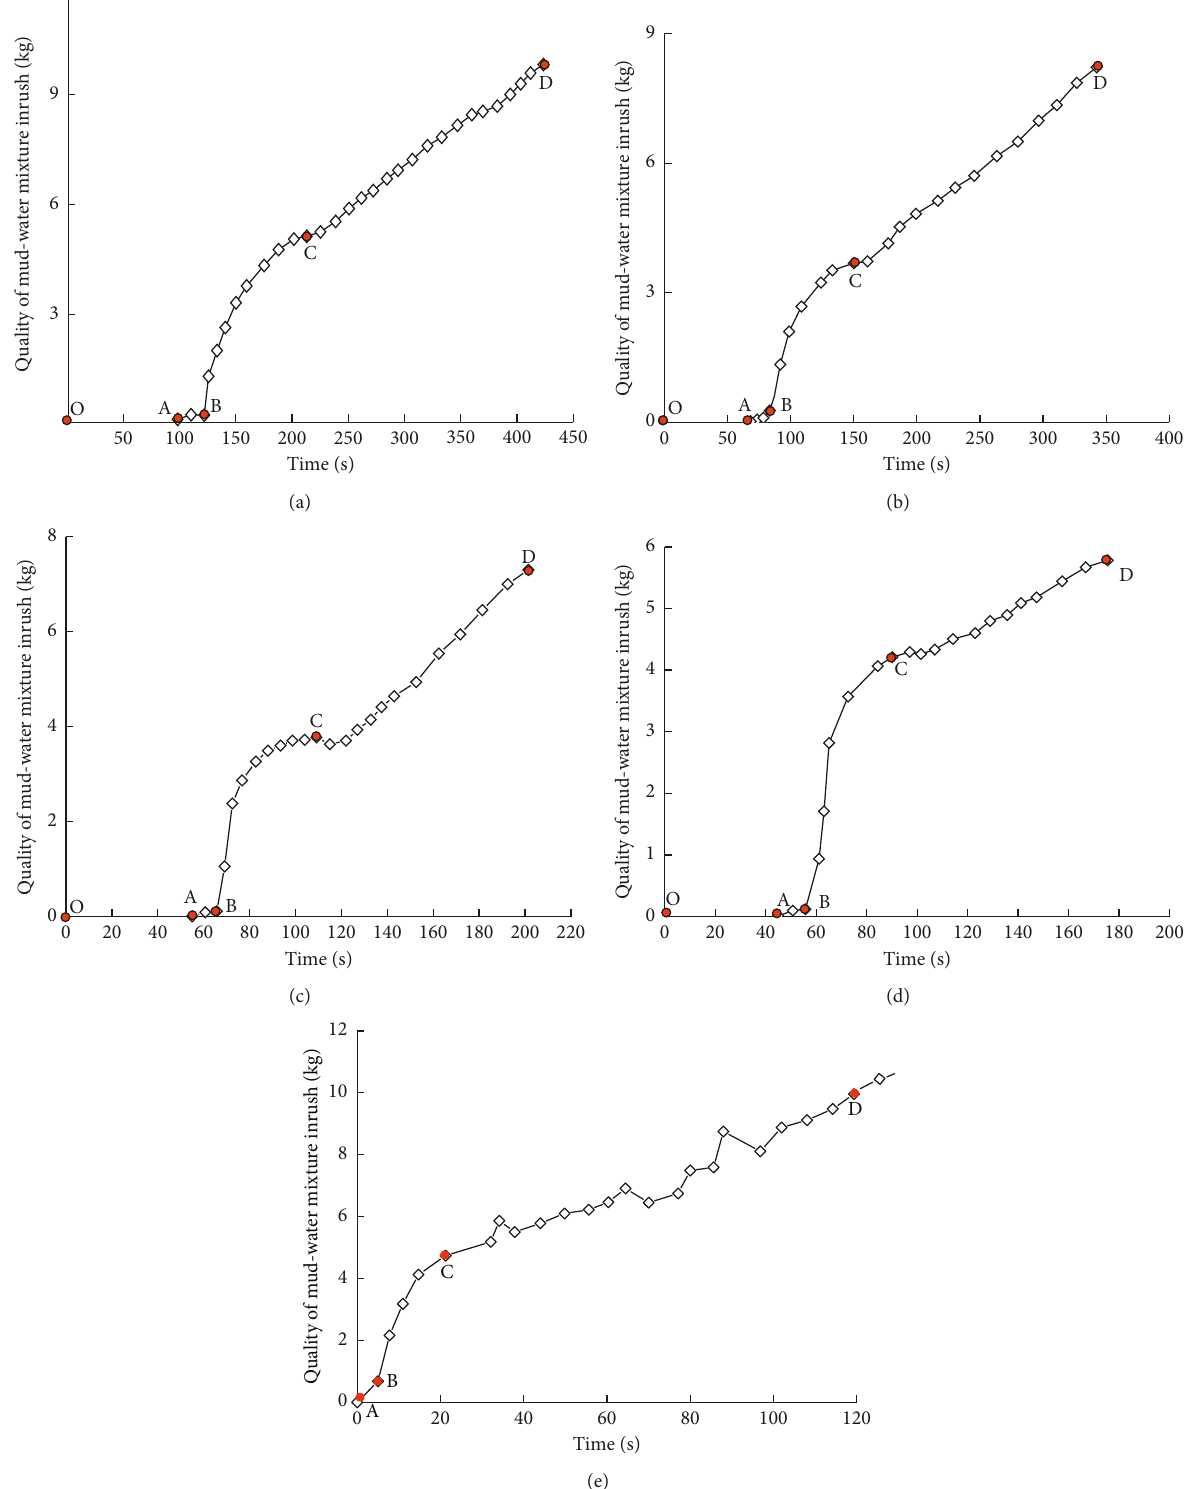
Figure 8: Characteristic curves of mud-water mixture inrush at the mud-water pressures of (a) 0.5, (b) 0.8, (c) 1.0, (d) 1.2, and (e)